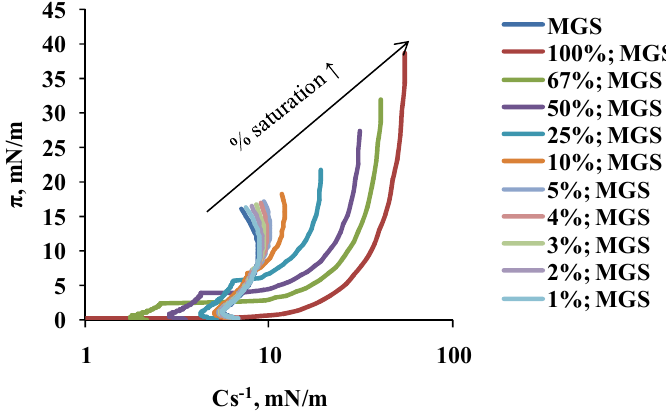
Figure 2. The dependence of surface pressure on isotherm reciprocal compressibility (Cs −1 ; shown on log scale) of MGS films (intact and with different degree of catalytic saturation). Cs −1 was calculated from the π/A isotherms shown at the upper panel of Figure 1 by Equation (2) (see Section 4.2.1). The lack of effect of ≤5% saturation on surface pressure/area isotherms and its proportionally increasing impact at ≥10% saturation on π max and Cs −1 correlate with the similar effects of % of saturation on acyl chain order, phase transition temperature, and cooperativity found in our previous study [16].